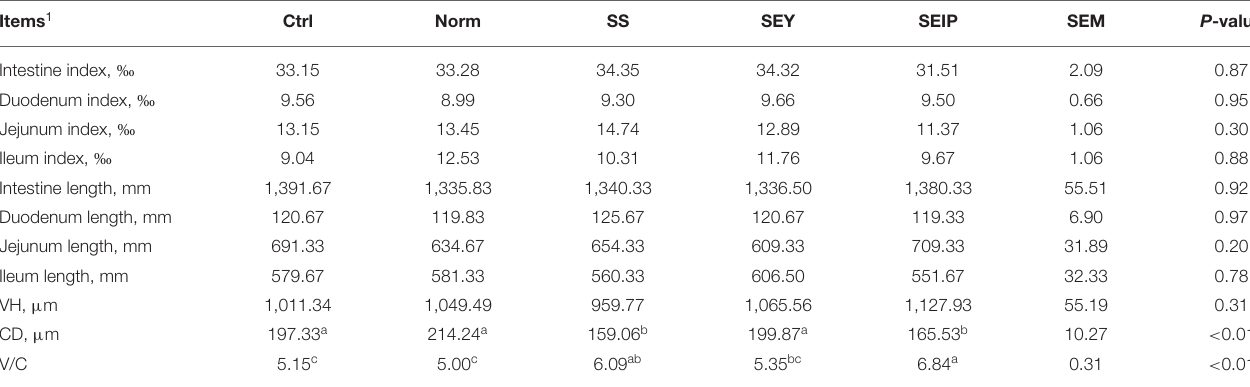
TABLE 8 | Effects of dietary Se sources on intestinal morphology of laying